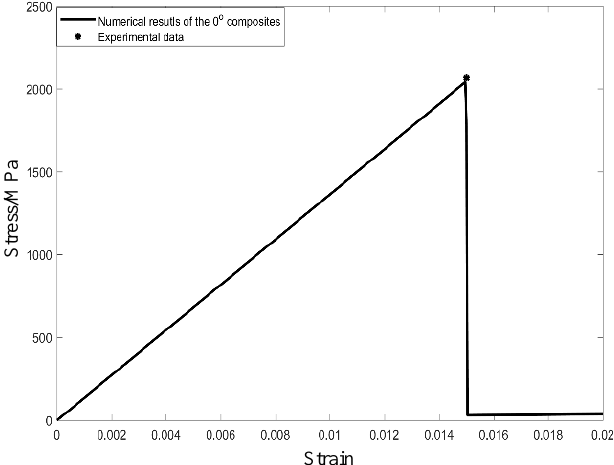
◦ Figure 3. Stress–strain curve of the 0 lamina at room Table 2. Longitudinal moduli study of composite laminates. Figure 3. Stress–strain curve of the 0 lamina at room temperature.